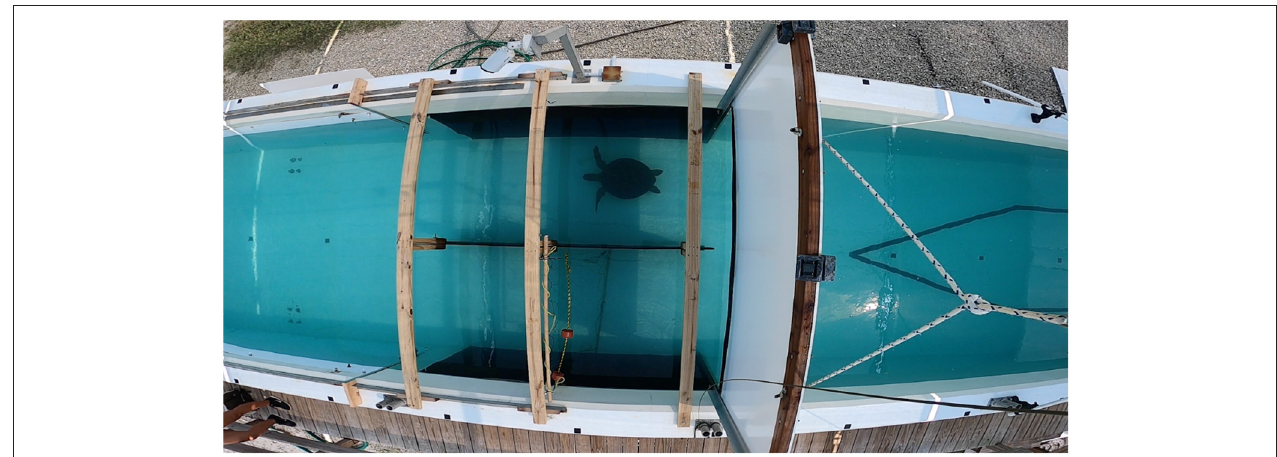
FIGURE 2 | Experimental tank at the St. Nuclear Power Plant in Jensen Beach, FL. A juvenile green turtle ( C. mydas ) is participating in a daytime net vs. no net trial. Image captured from the primary overhead camera used to record all experiments.